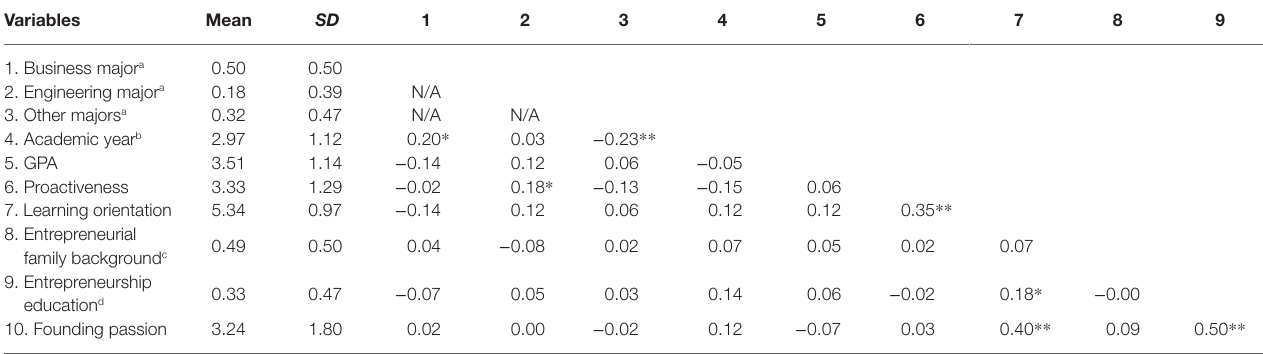
TABLE 2 | Summary statistics and correlations matrix. Variables